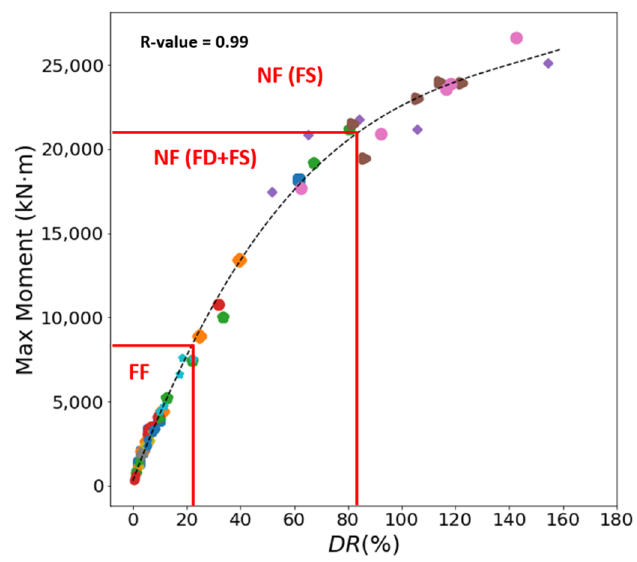
Figure 13. Maximum moment with increasing bridge height: ( a ) Maximum moment under near-fault ground motion; ( b ) Maximum moment under far-fault ground motion.